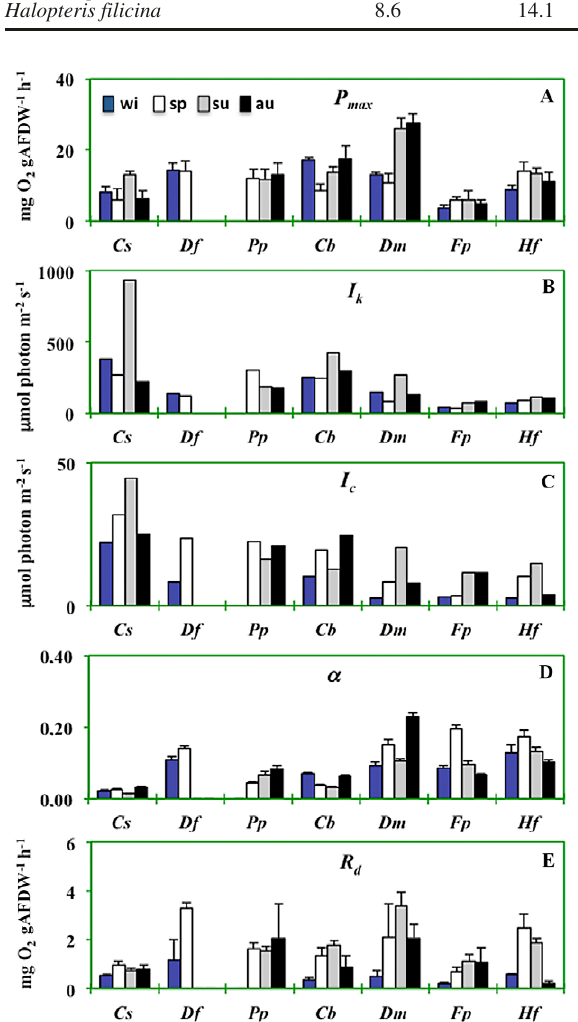
Fig. 4. – Seasonal values of the photosynthetic parameters: photo- synthesis at saturation (P ), light at saturation (I ), light at com- max k pensation (I ), photosynthetic efficiency ( α ) and dark respiration c (R ). Cs, Carpodesmia stricta ; Df, Dictyota fasciola ; Pp, Padina d pavonica ; Cb, Carpodesmia balearica ; Dp, Dictyopteris polypodi- oides ; Fp, Flabellia petiolata ; Hf, Halopteris filicina .